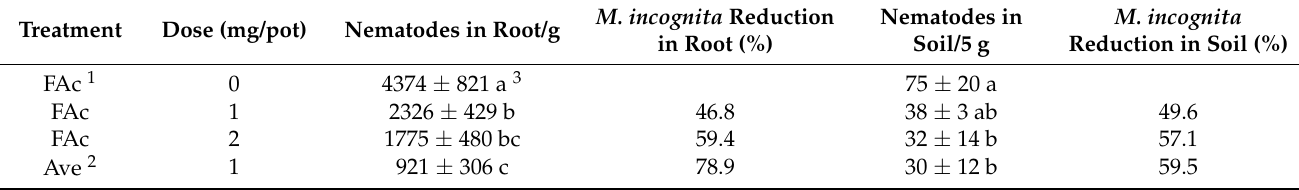
Table 1. Suppression of M. incognita by FAc in tomato plants in pot